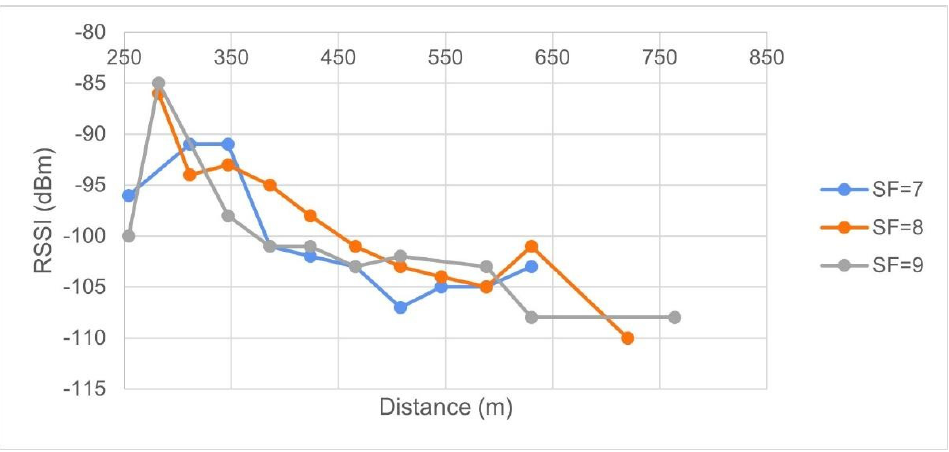
Figure 13. RSSI versus distance with BW = 125 kHz and CR = 4/6, in Experiment 4.